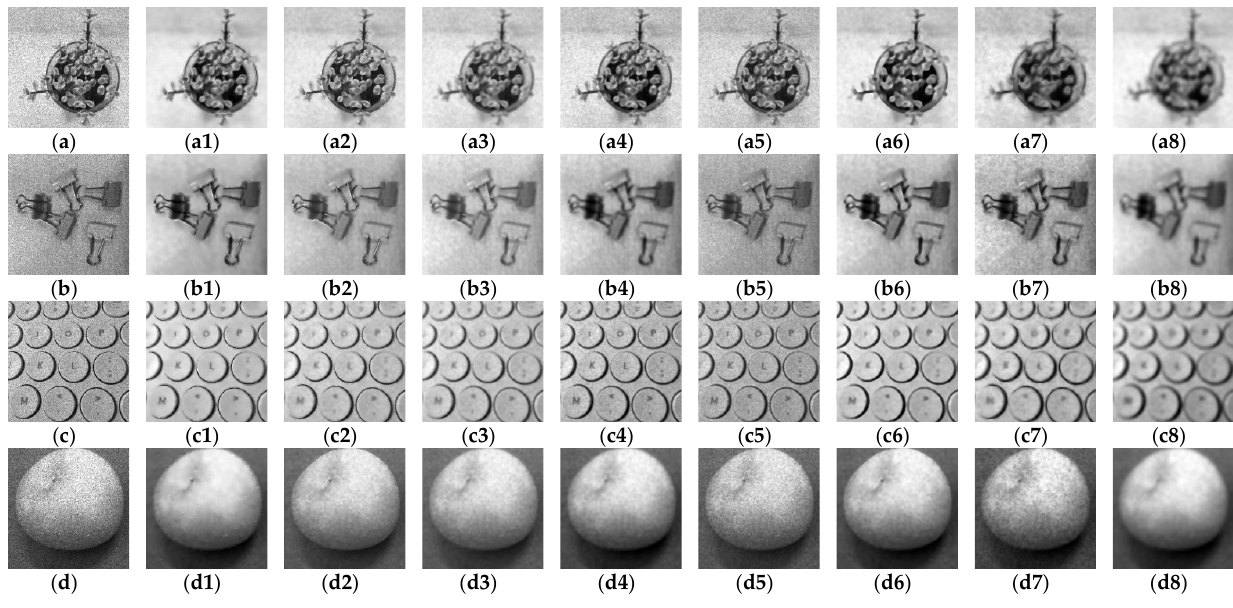
Figure 15. Experimental results of four optical images: ( a1 - 8 ) are the denoising results for the Plant of our method, Lee filter, traditional Frost filter, SRAD, NLM, RGF, EDS, and SAR-IRGF, respectively. ( b1 - 8 ) are the denoising results for the Clamps of our method, Lee filter, traditional Frost filter, SRAD, NLM, RGF, EDS, and SAR-IRGF, respectively. ( c1 - 8 ) are the denoising results for the Keyboard of our method, Lee filter, traditional Frost filter, SRAD, NLM, RGF, EDS, and SAR-IRGF,